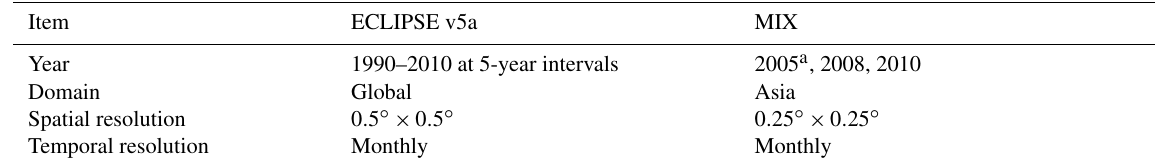
Table 1. Key features of ECLIPSE v5a and MIX emission